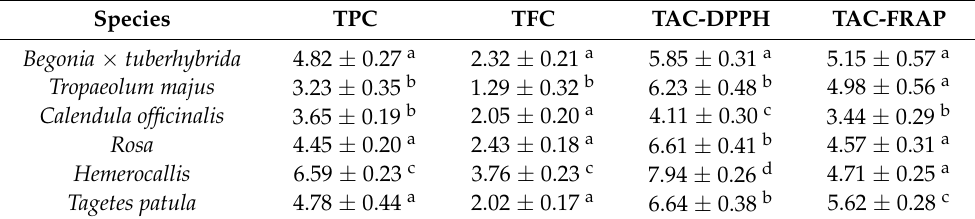
Table 3. Total phenolic content (g of GAE/kg of FM), total antioxidant capacity (g of AAE/kg of